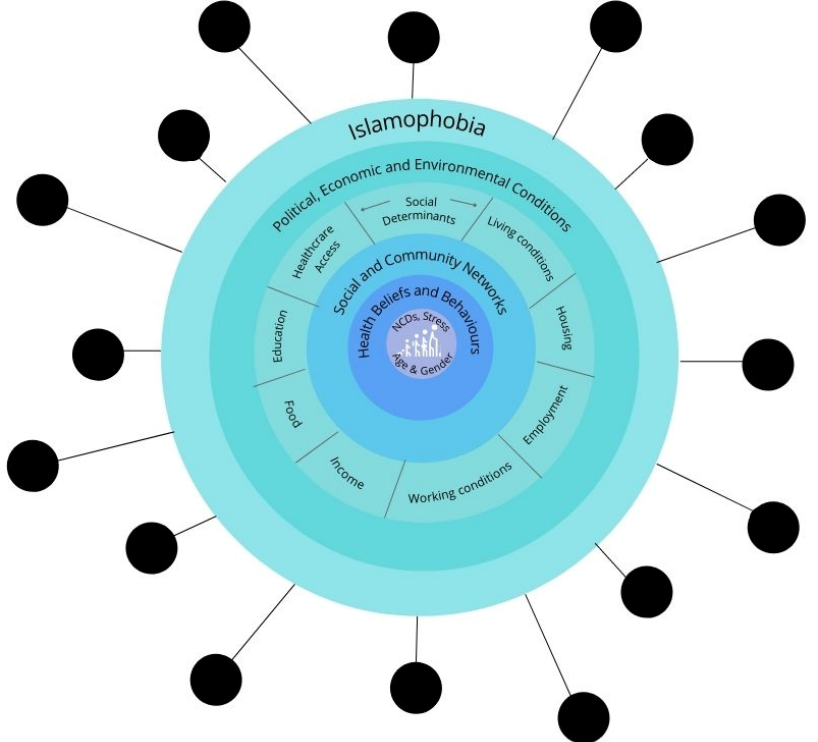
Figure 1. The syndemic of Islamophobia, social determinants of health and health inequities in the Muslim community in Britain.